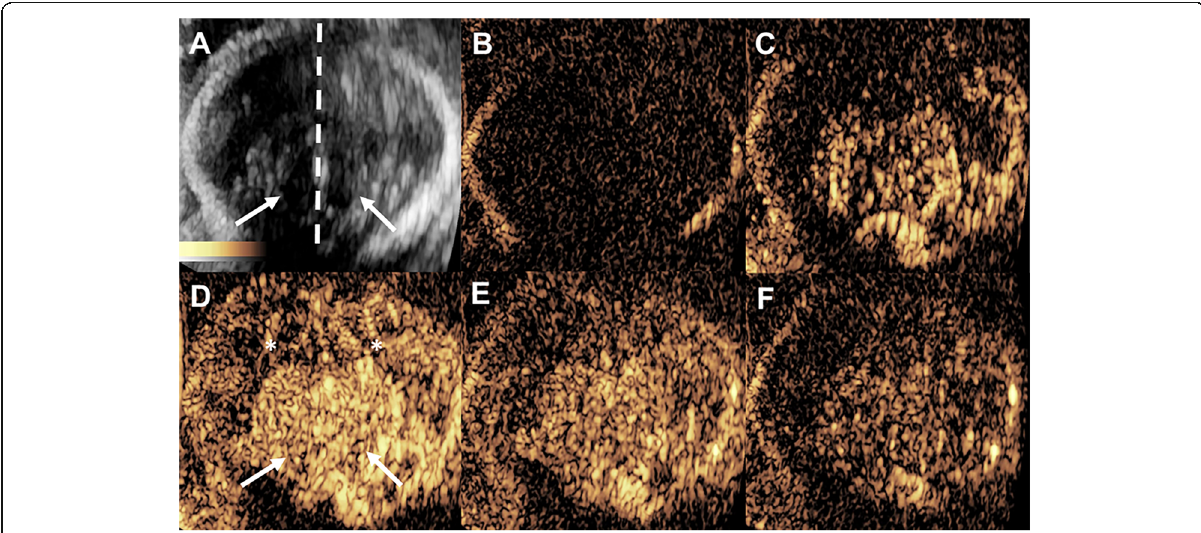
Fig. 2 Representative images from contrast-enhanced ultrasound examinations through the fetal brain in at various timepoints during ex utero transaxial imaging evaluation with a , grayscale image for localization including thalami (arrows), brain parenchyma (asterisks), and midline denoted by the dotted line and b , baseline contrast optimized image. Following bolus ultrasound contrast administration, brain parenchymal perfusion is visualized at c , early wash-in, d , maximum enhancement of the thalami (arrows) and brain parenchyma (asterisks), e , early wash-out, and f , late